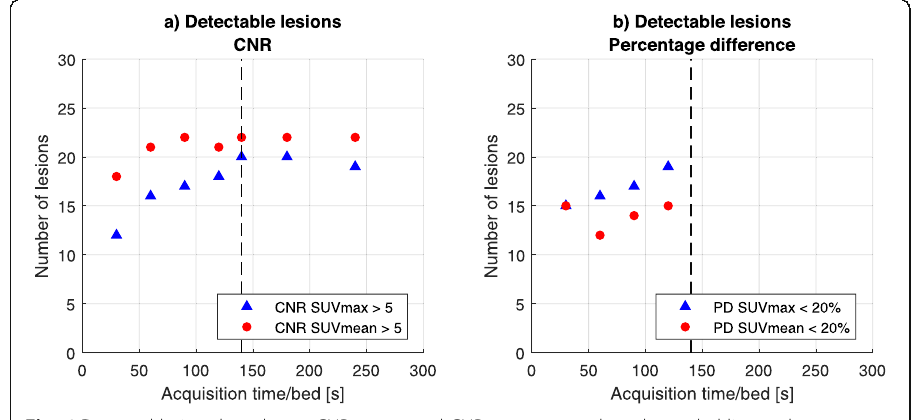
Fig. 6 Detected lesions based on a CNR SUVmean and CNR SUVmax > 5 at the subsampled list-mode reconstructions with acquisition times (240, 180, 120, 90, 60, and 30 s/bed) and b PD SUVmean and PD SUVmax < 20% at the subsampled list-mode reconstructions with acquisition times (120, 90, 60, and 30 s/bed). In both graphs, the proposed acquisition time 140 s/bed is indicated (vertical dotted